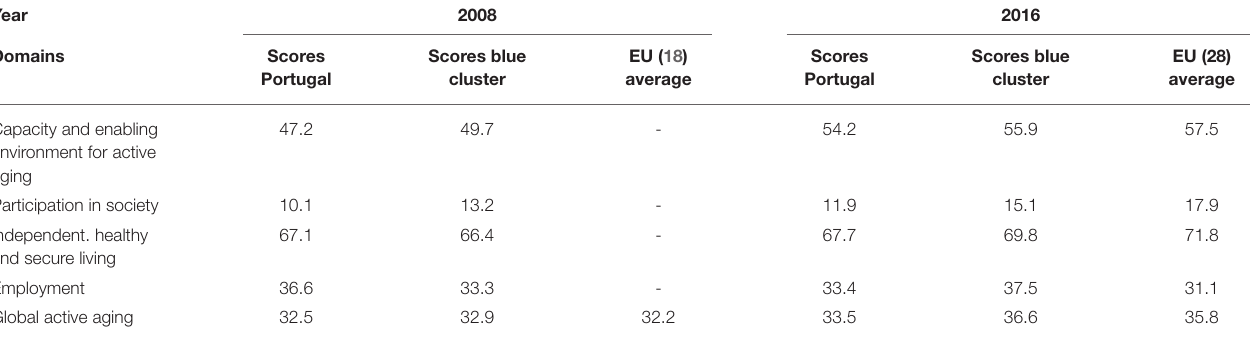
TABLE 1 | Trends of the Portuguese, Blue Cluster and 28 European Union’s scores for Active Aging Index and its domains between 2008 and